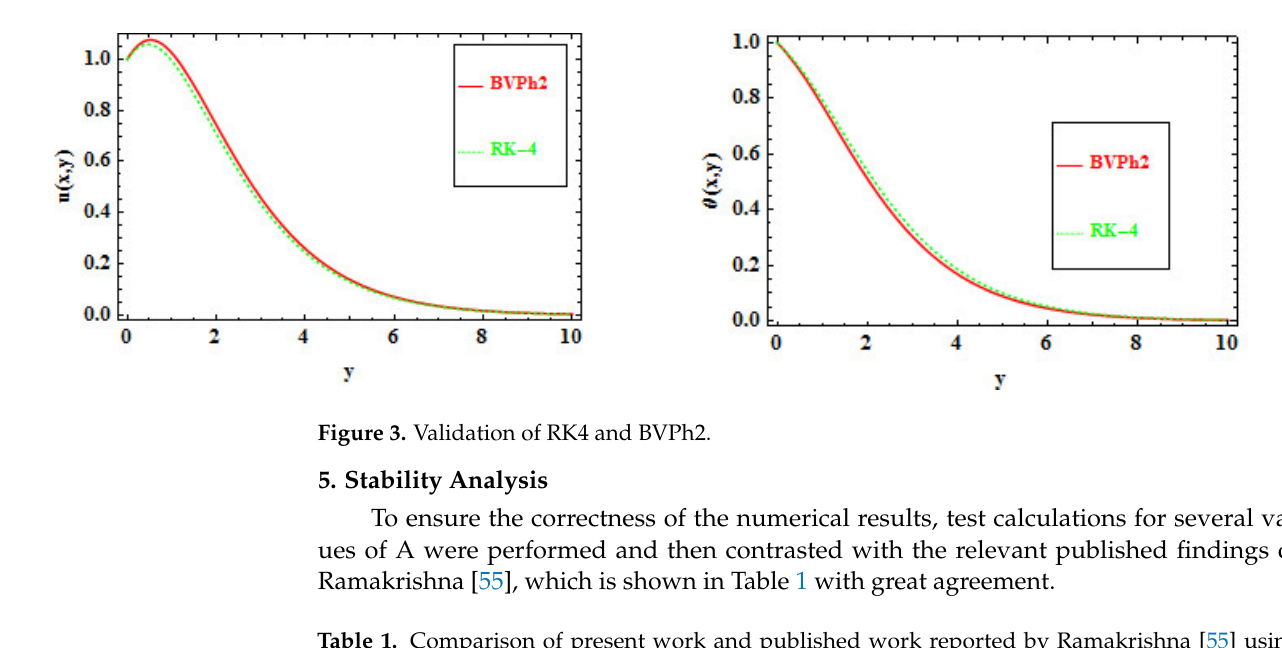
Table 1. Comparison of present work and published work reported by Ramakrishna [55] using Gr = Grm = 2, Pr = 0.1, Q = 0.5, Ec = 0.1, Prm = 0.5, S 0 = 0.7, Sc = 2 for different values of Sc